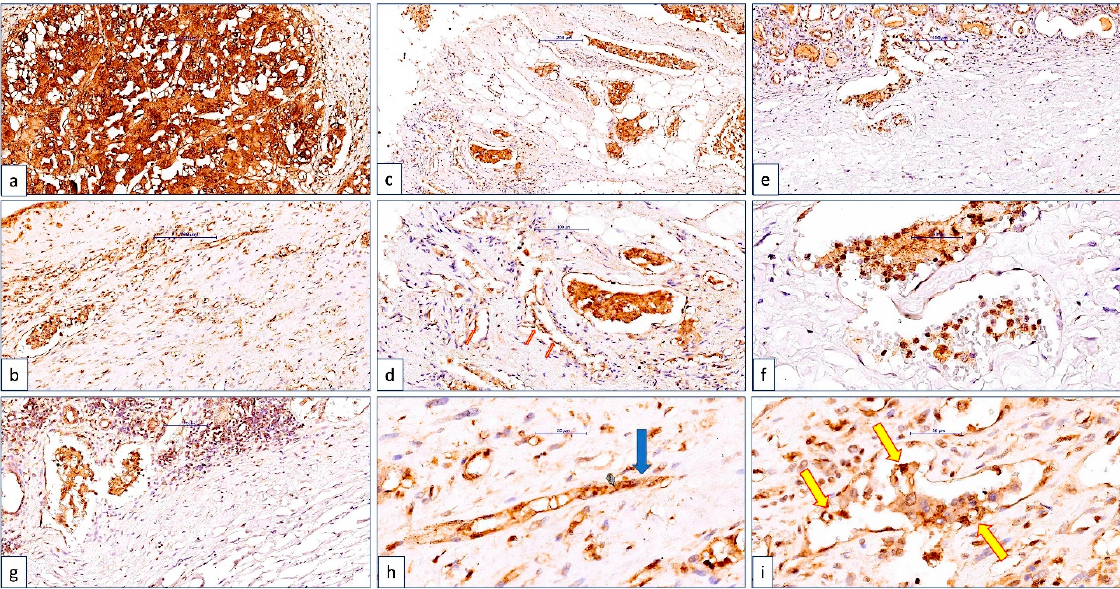
Figure 4. CLIC1 expression overview in a ccRCC case classified as pT4NxM1L1V1. The tumor area was strongly positive for CLIC1, with an NMC pattern ( a ). We detected intravascular CLIC1-positive tumor emboli in both small ( b ) and large vessels around the tumor ( c , d ), but also in capsular and subcapsular vessels of the adjacent kidney parenchyma far from the tumor ( e , f ). Large and small vessels of the endothelium lining were also positive for CLIC1. A particular aspect of CLIC1- positive tumor blood vessels was observed related to their morphology. CLIC1-positive intravascu- lar pillars ( d , red arrows), along with CLIC1-positive endothelial cell cords, which are highly sug- gestive of angiogenic sprouts ( h , blue arrow), indicated a high angiogenic process around the tumor. A frequent phenomenon observed for CLIC1-positive cases, especially those with pT3a, 3b, and 4 regarding the angiogenic tumor vessels, was the interrelationship between intravascular emboli tu- mor cells, which were often interconnected with endothelial cells. Tumor cells and endothelial cells delineated spaces mimicking a new vascular luminal structure inside the existing vessels ( i , yellow arrows). Capsular and subcapsular vessels containing CLIC1 tumor emboli were often associated with inflammation in the proximity ( g ). The most CLIC1-positive tumor blood vessels were found in the pT4 case s (75 vessels/X20 microscopic field ; Figure 5 ). Scale bar: 200 μ m for images a, c, e; 100 μ m for images b, d, f; 50 μ m for images g, h, i.